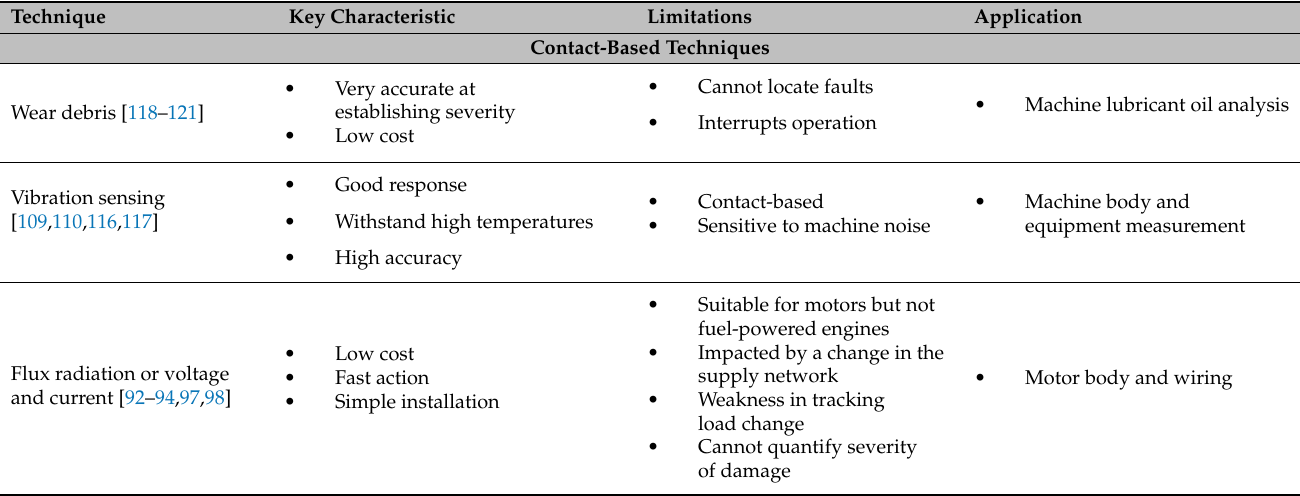
Table 1. Suitability matrix of NII techniques for different